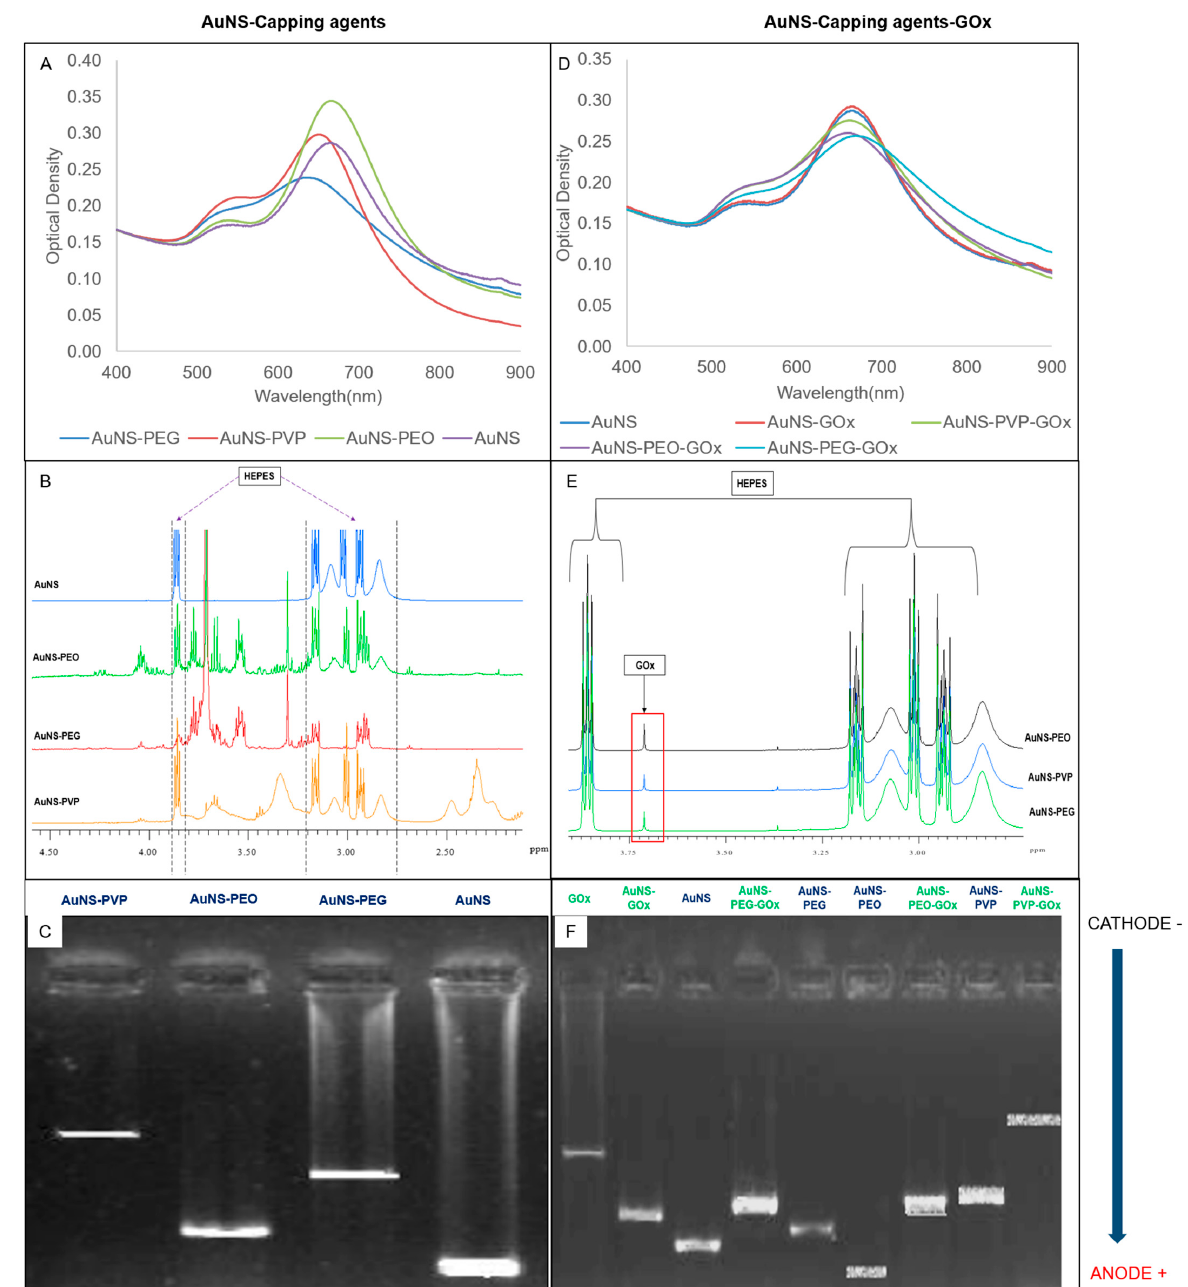
Figure 1. ( A – C ) Effects of capping agents on AuNSs using ( A ) UV-vis spectrometry, ( B ) nuclear magnetic resonance (NMR), and ( C ) gel electrophoresis. ( D – F ) AuNS capping agents functionalized with glucose oxidase using ( D ) UV-vis spectrometry, ( E ) NMR, and ( F ) gel electrophoresis. TEM images of capped (top row) and bioconjugated (bottom row) AuNSs are pre- sented in Figure 2. AuNS (Figure 2A), AuNS-PVP (Figure 2B), and AuNS-PEG (Figure 2D) particles were moderately monodispersed, with an estimated average size ranging from 40 to 42 nm. Most AuNS-PEO particles (Figure 2C) were cleaved during the capping pro- cess, with resultant tripod or tetrapod appearances and an average diameter of 25 nm.